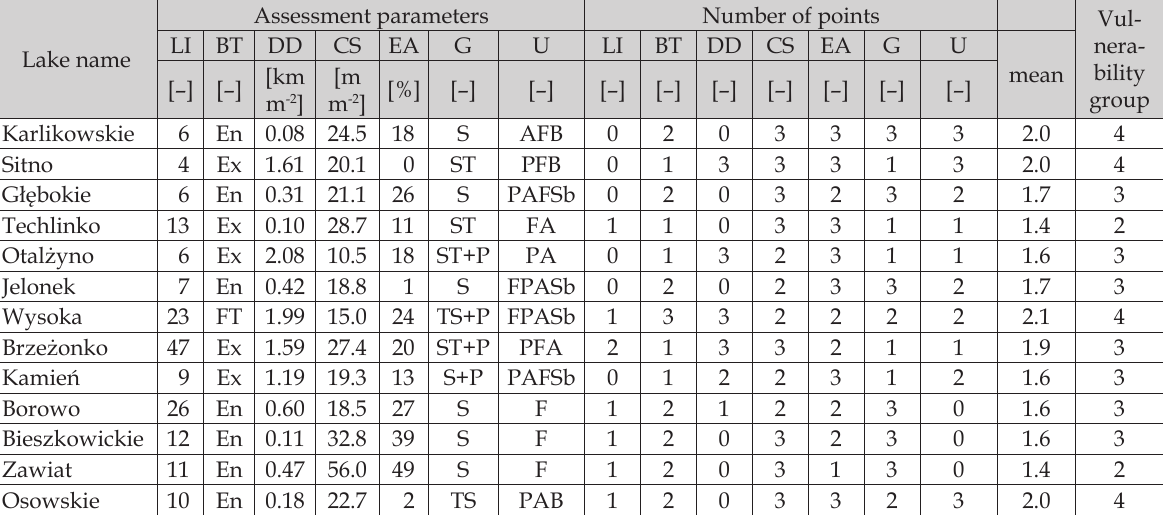
Table 3. Point assessment of catchment vulnerability of lobelia lakes of Tricity area to matter supply to lakes Lake